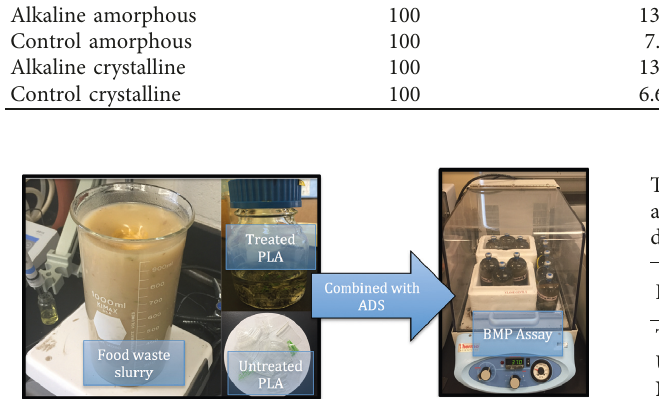
Figure 1: BMP assay setup consisting of food waste, PLA (treated or untreated), and anaerobic digested sludge (ADS).